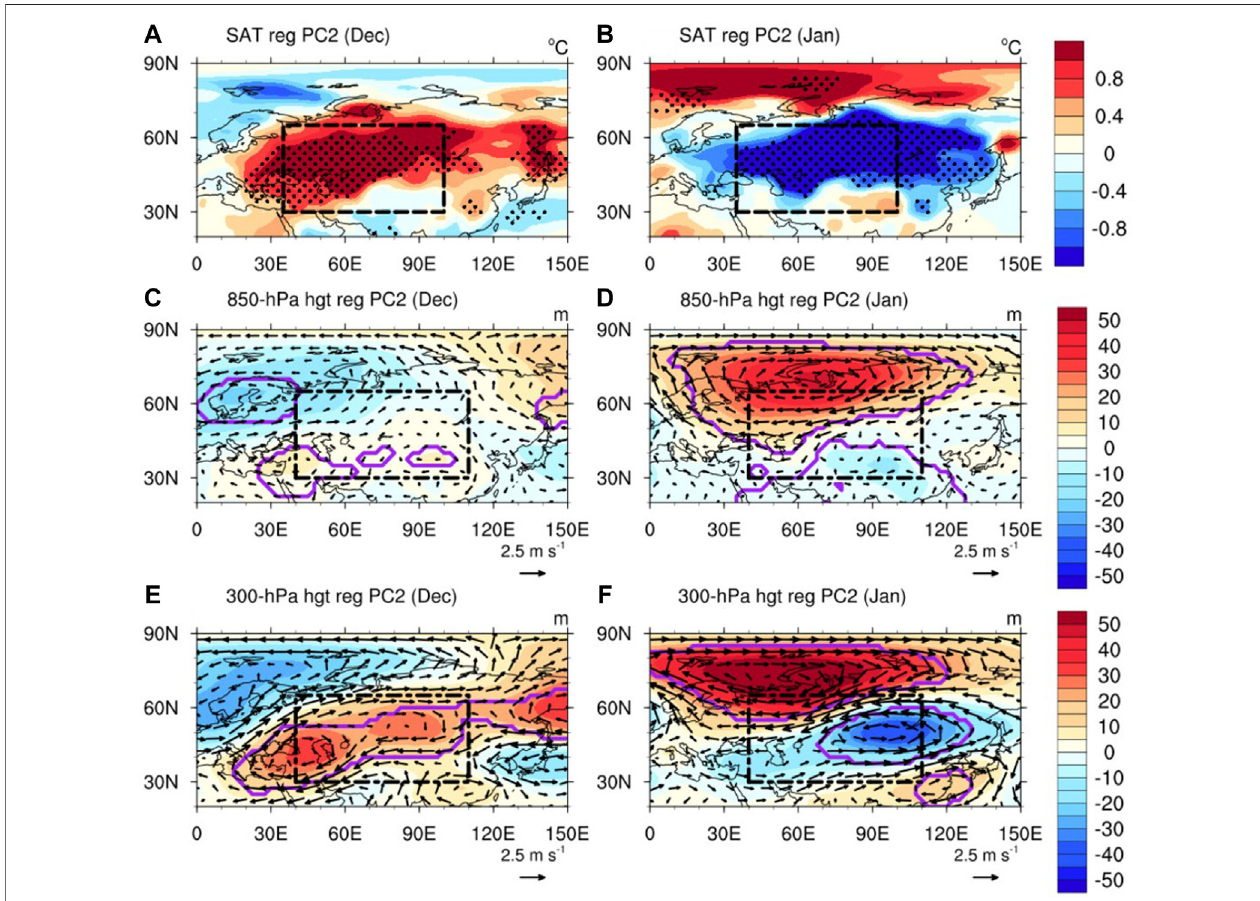
FIGURE3| RegressionsofDecember (A) SAT(shading; ° C)and(C)850 hPaand(E)300 hPageopotentialheight(shading;m)and winds(vectors; m s − 1 )ontothe PC2fortheperiod1979 – 2017 (B,D,F) Asin (A,C,E) butforJanuaryduring1980 – 2018.TheblackdashedboxesshowtheregionofCA;anomaliessigni fi cantatthe95% con fi dence level are denoted by dots and purple contour lines, as estimated by the Student ’ s t- test.